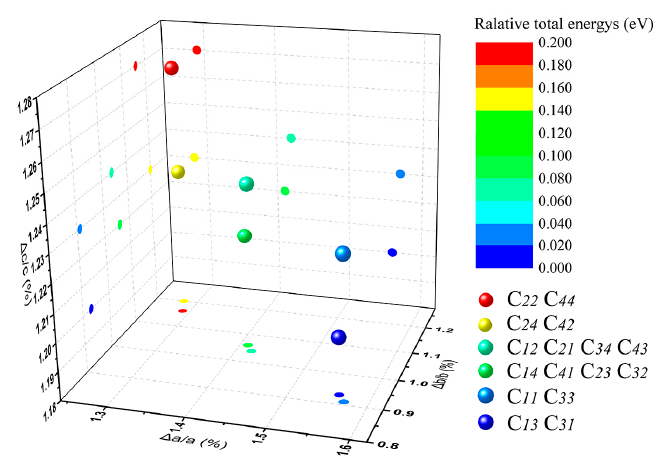
Figure 3. The relative deviations of cell parameters and total energy of sixteen configurations.